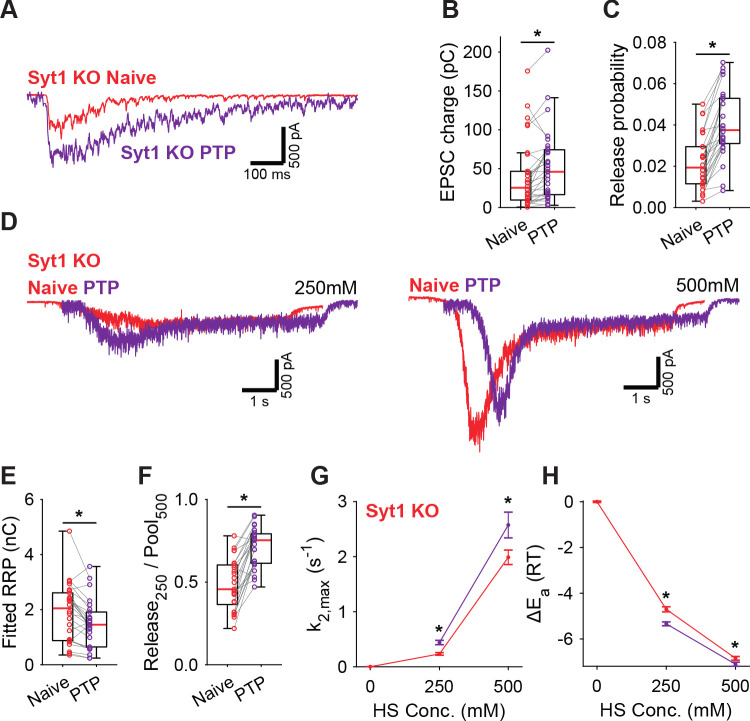
Post-tetanic potentiation decreases the fusion energy barrier independent of Syt1.(A) Representative traces of AP-evoked release before (Naive) and after PTP in Syt1 KO synapses, overlaid, and (B) boxplots of charge transferred during the first evoked EPSC and (C) release probability calculated by dividing the EPSC charge by the HS-derived RRP charge (E). (D) Representative traces of HS-induced release before and after PTP, overlaid with 1 s offset, at 250 mM and 500 mM HS, and boxplots of (E) RRP charge estimated from 500 mM HS, and (F) depleted RRP fraction at 250 mM HS before (Naive) and after PTP. (G) Plots (mean ± S.E.M.) of maximal HS release rates, and (H) change in the fusion energy barrier at different HS concentrations before (Naive) and after PTP. (*p<0.05, Wilcoxon signed-rank test).
Figure 5—source data 1.Statistics overview.